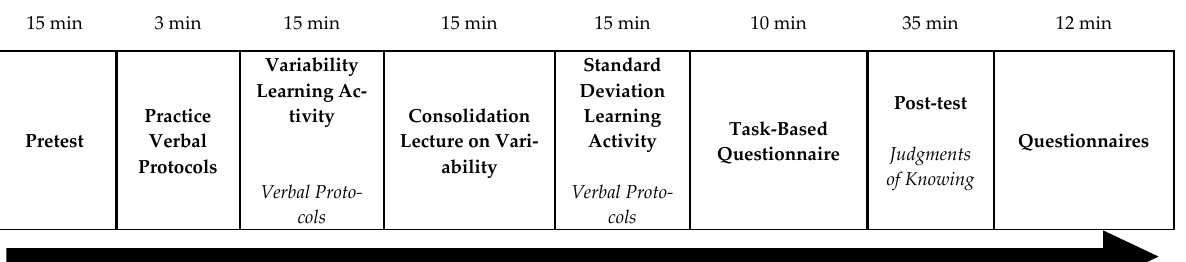
Figure 4. Design summary. The three metacognitive measures captured in this work are italicized. The arrow shows the direction of the ordered activities. The arrow shows the direction of the ordered